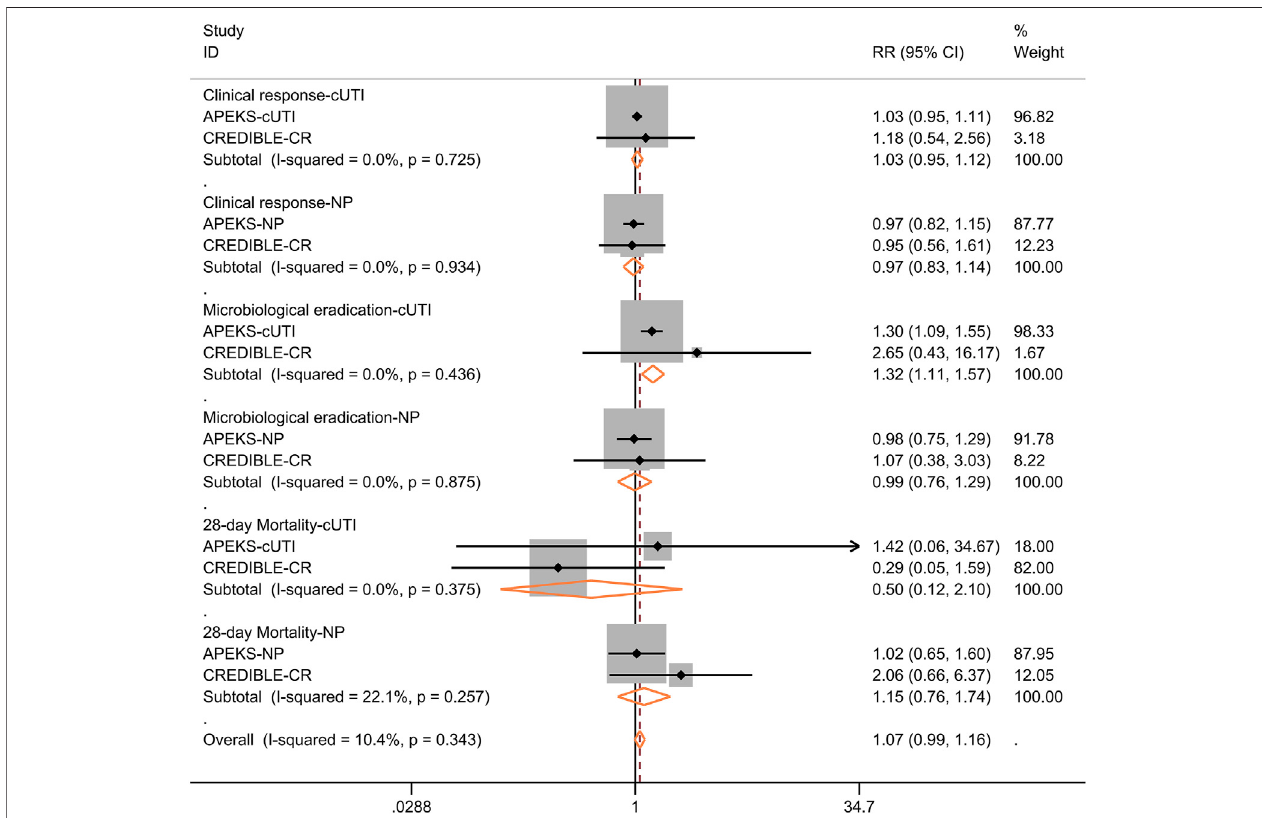
FIGURE5| Forestplotforthepooledanalysisofclinicalresponseattestofcure,microbiologicalresponseand28-daysall-causemortalitybetweence fi derocoland comparators for the treatment of complicated urinary tract infection (cUTI) or nosocomial pneumonia (NP).